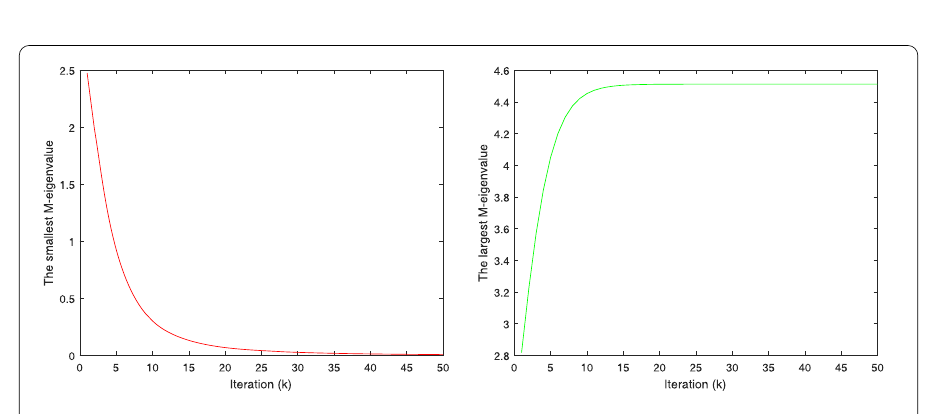
Figure 2 Numerical result of Example